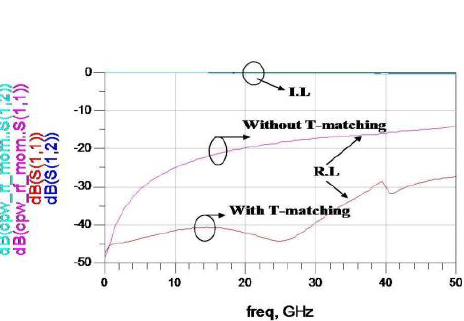
Figure 6: Improvement of RF performance by T-match circuit